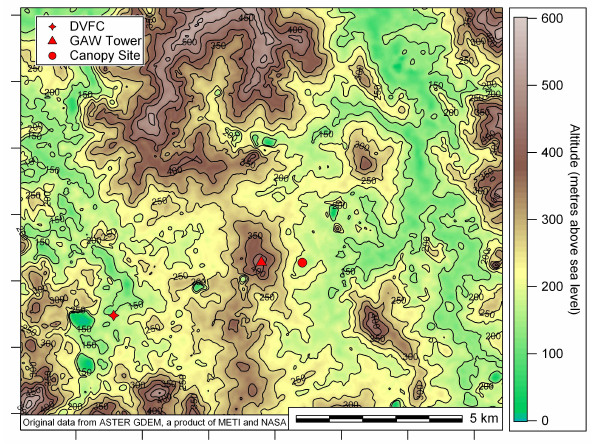
Fig. 1. Relief map of the area showing site locations. Original data of ASTER GDEM is the property of METI and NASA.